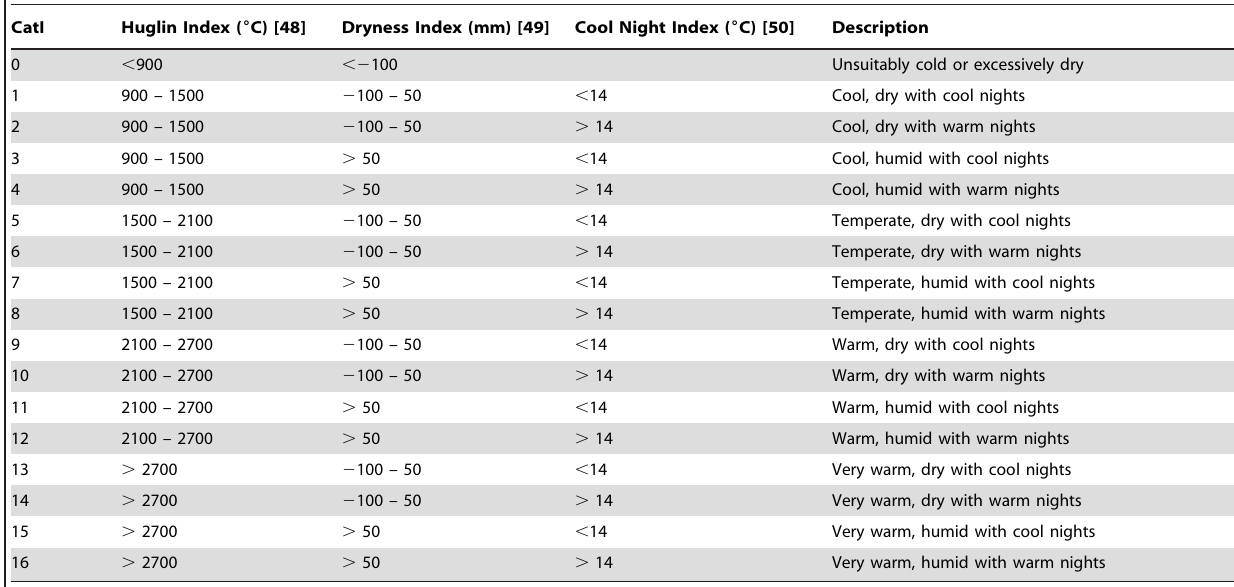
Table 1. Categorized Index (CatI), along with the corresponding classes of the combined indices: Huglin, Dryness and Cool Night indices, according to